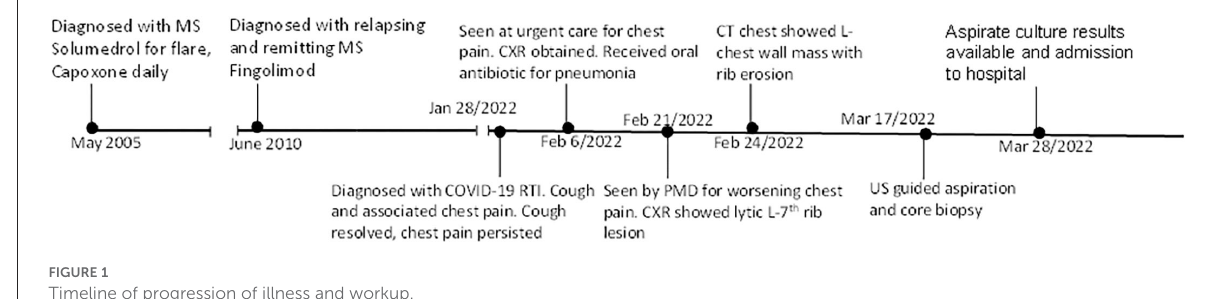
FIGURE1 Timeline of progression of illness and workup.